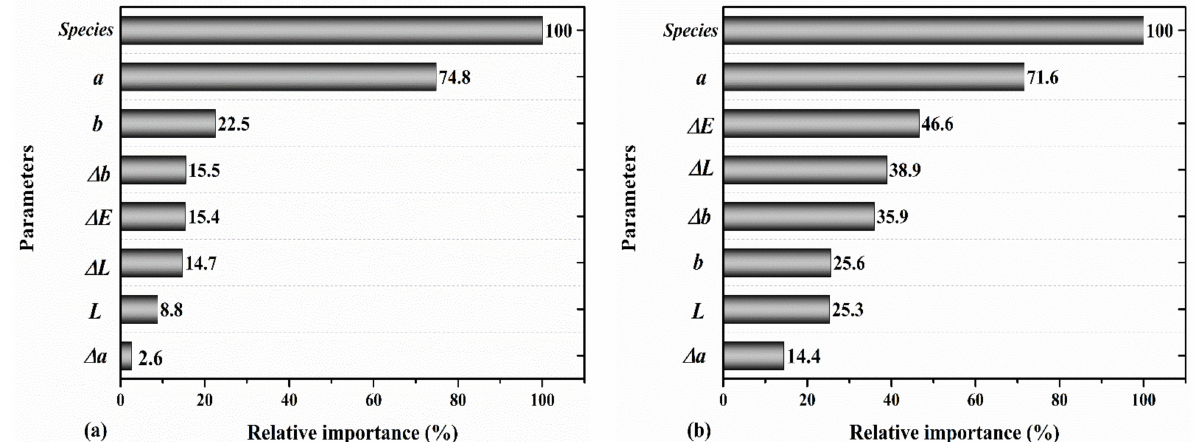
Figure 11. The relative importance of wood species, a , b , L , ∆ E , ∆ a , ∆ b , and ∆ L for predicting the ( a ) MOE and ( b ) MOR.